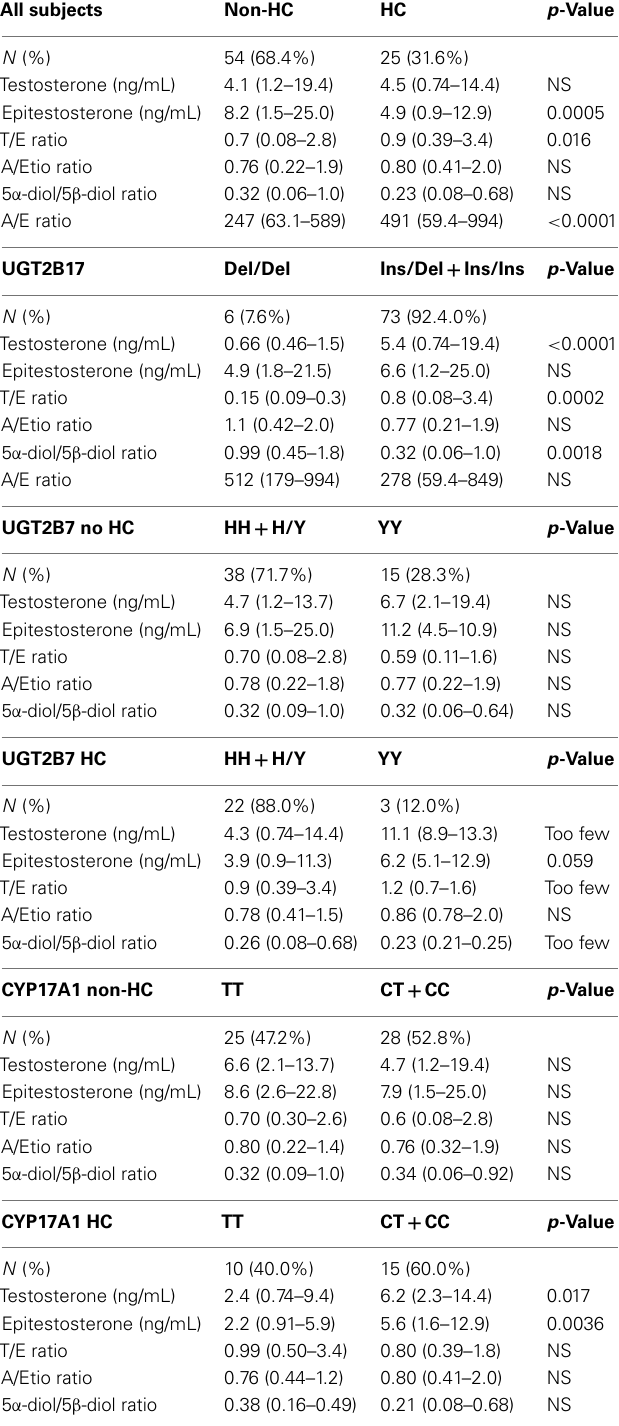
Table 1 | Comparison between urinary steroid profiles for the non-HC and HC group as well as urinary steroid profiles for different genotypes.